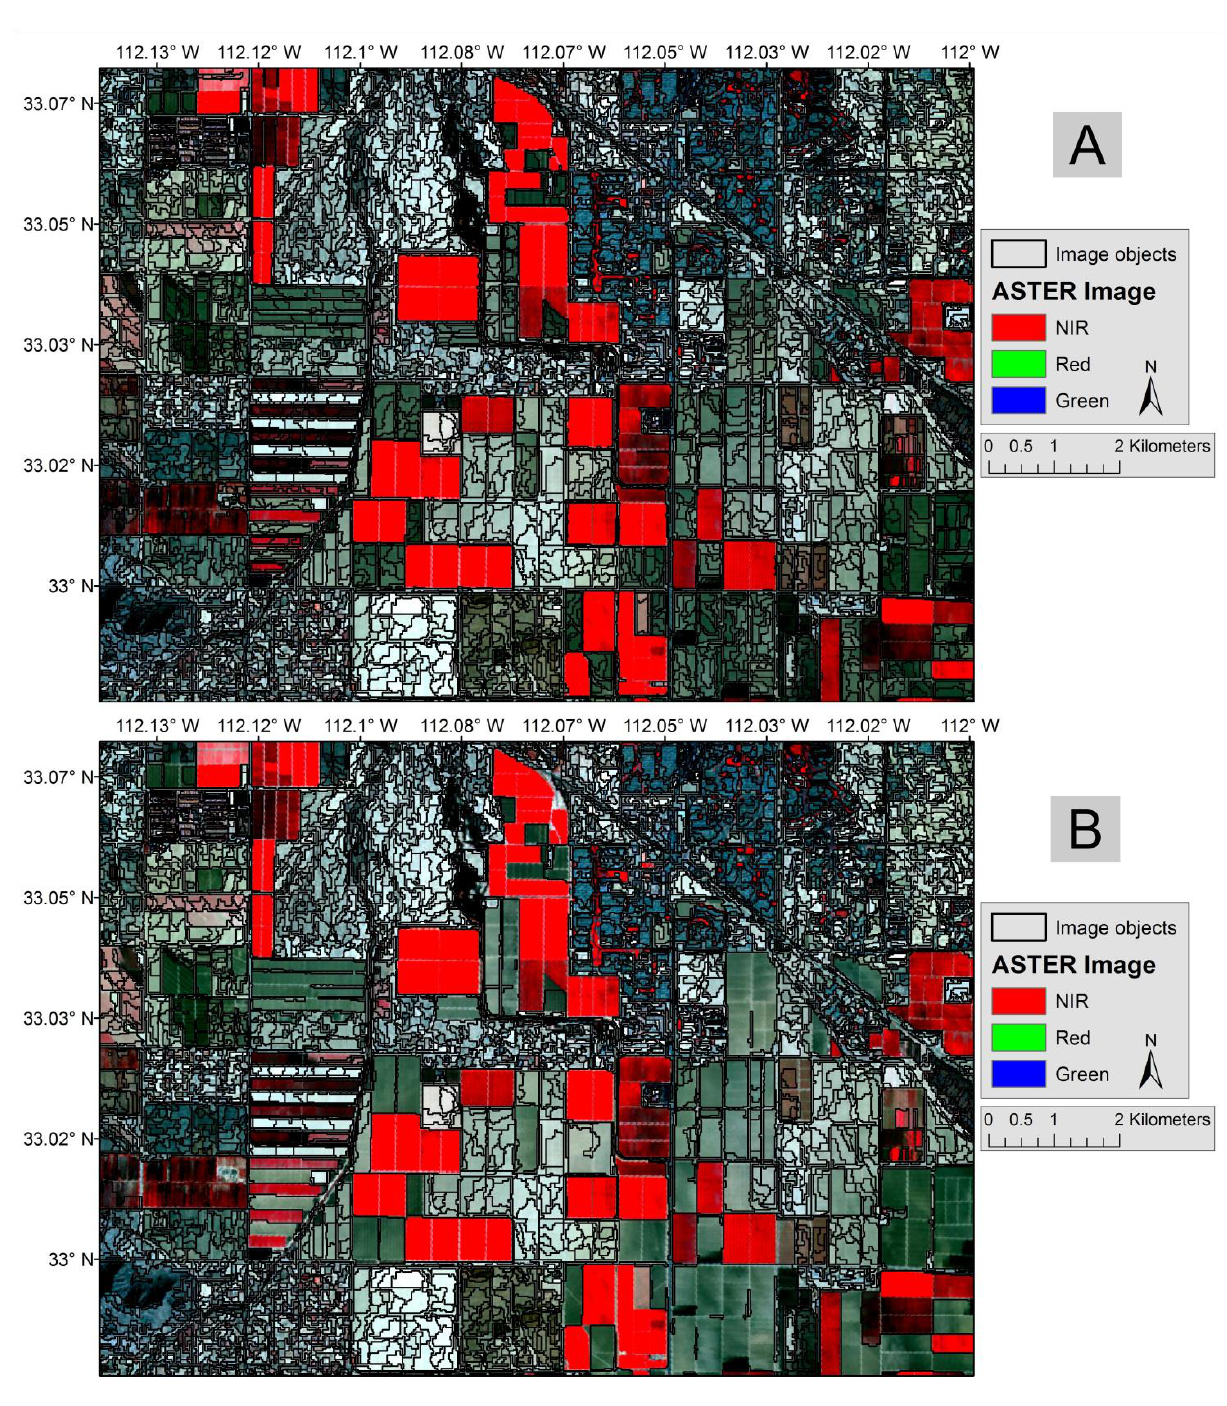
Figure 4. Comparison of objects before ( A ) and after ( B ) a merge of very low